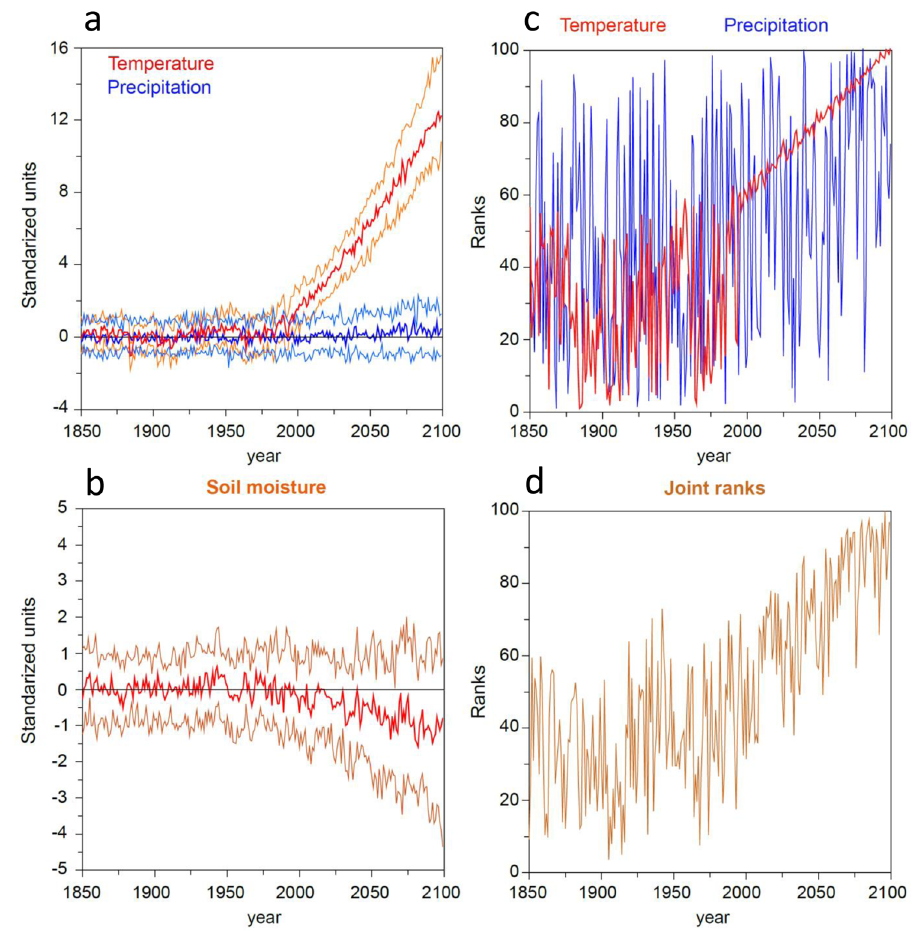
Fig. 4 Model ensemble output for Southwest precipitation, temperature, soil moisture. MODEL (CMIP6, SSP585) ensemble temperature and precipitation ( a ), soil moisture, b , and temperature, precipitation, and joint rankings ( c , d ). a , b show 20th and 80th percentile values along with ensemble median. c , d show median values; 20th and 80th percentile values are highly similar in structure. Rankings are normalized between 0 and